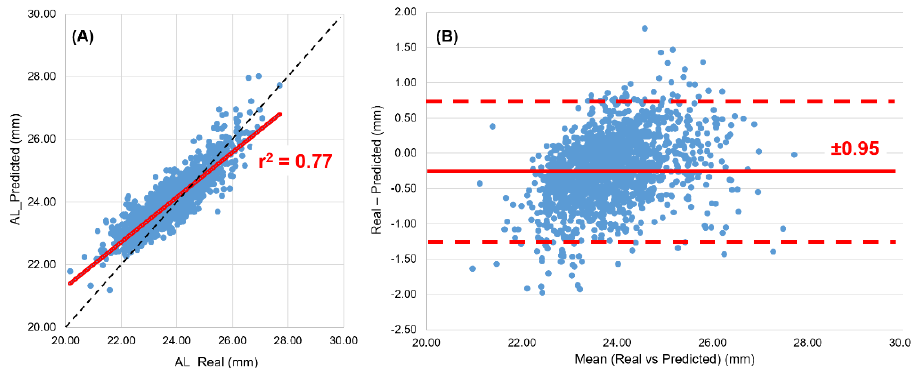
Figure 1. Linear regression ( A ) and Bland–Altman ( B ) analysis between AL_Real (obtained with IOL master) and AL_Predicted (calculated using the Morgan model).